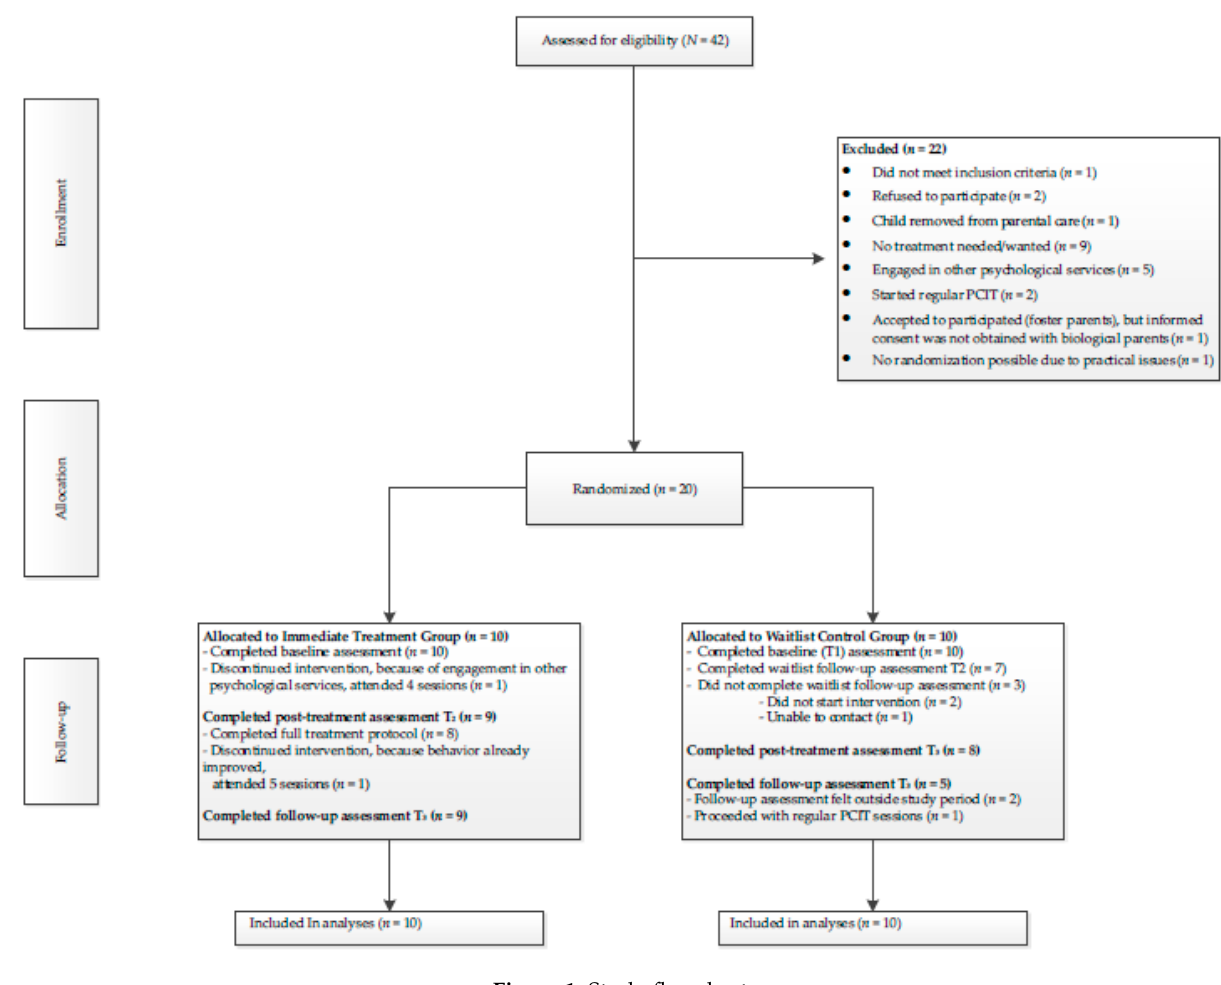
Figure 1. Study Figure 1. Study flowchart.